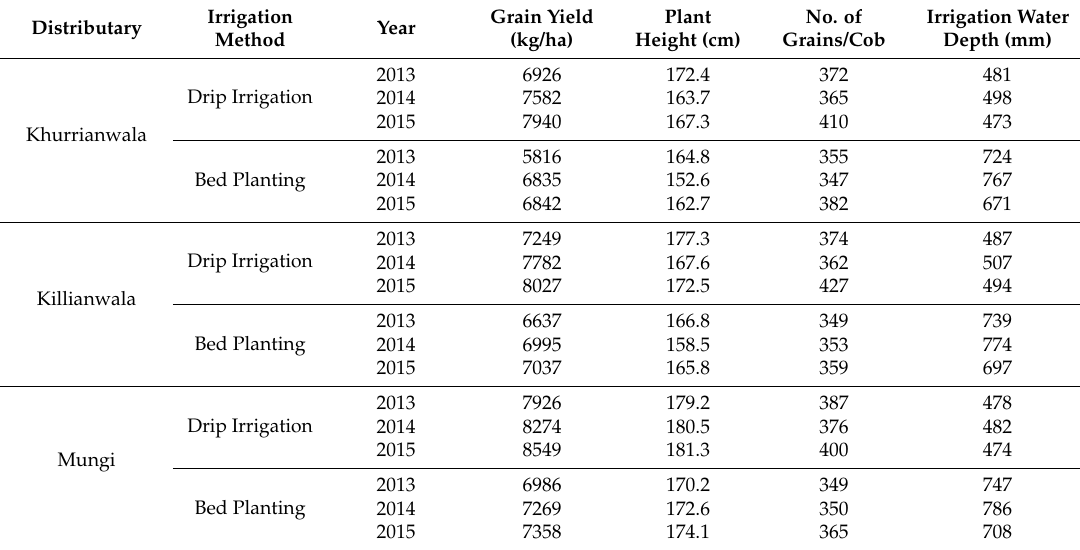
Table 9. Water saving and yield increments of maize crop under drip